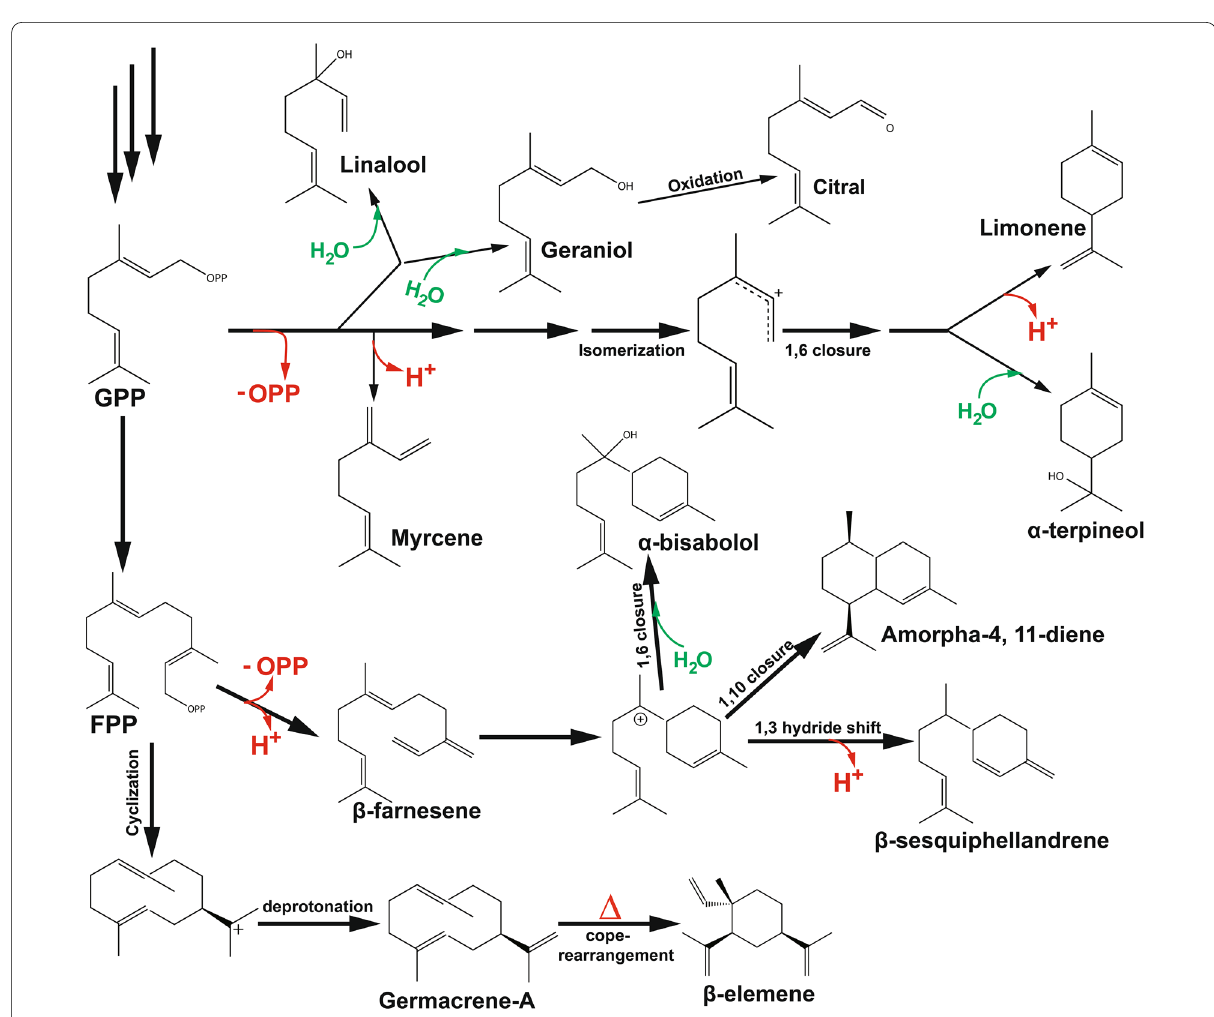
Fig. 2 Proposed mechanism of terpenoid carbonation. Terpenoids undergo a wide range of cyclization and rearrangements to ensure final product